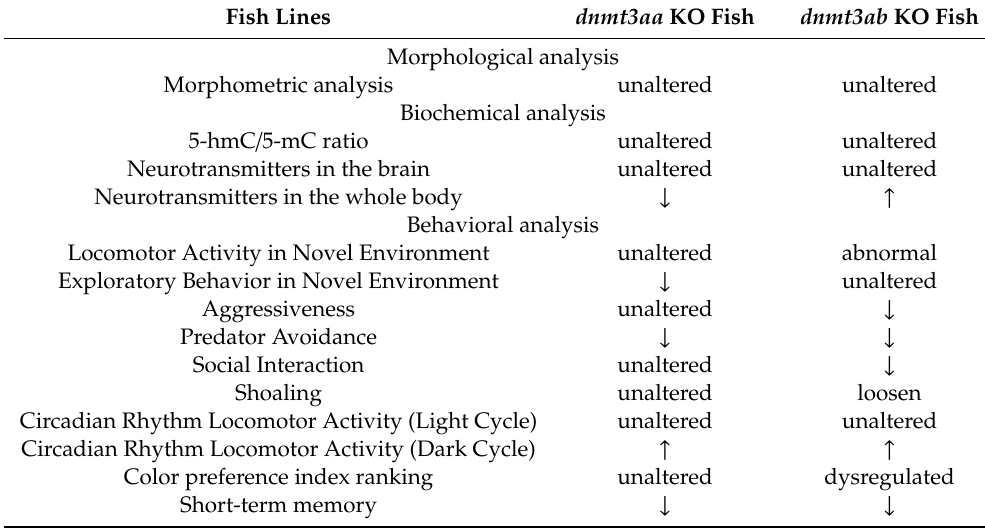
Table 4. Summary of dnmt3aa and dnmt3ab KO zebrafish phenotypes collected at morphological, biochemical, and behavioral levels compared to the control group. The signatures of the zebrafish behavioral and biochemical tests are summarized ( ↓ : downregulated, ↑ : upregulated). Fish Lines dnmt3aa KO Fish dnmt3ab KO Fish